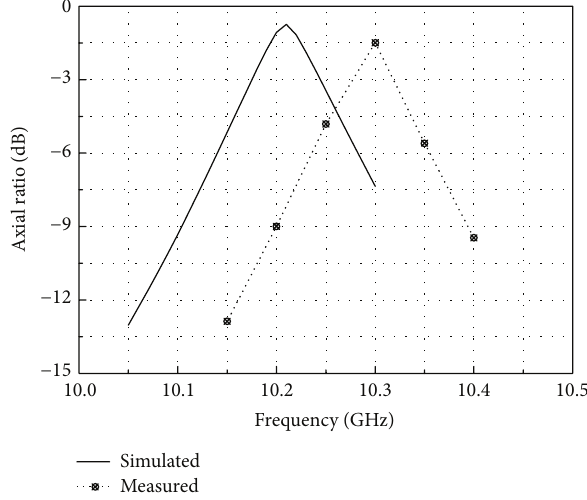
Figure 7: AR of the fabricated antenna at the boresight direction.